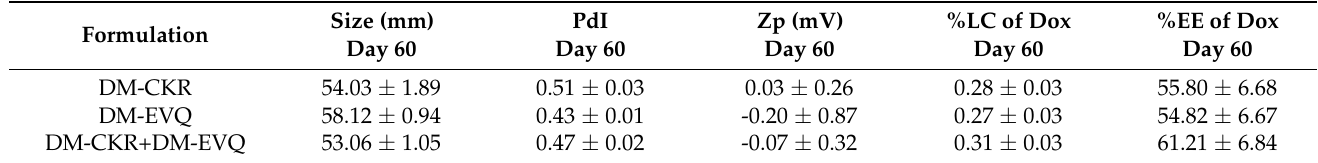
Table 3. Particle size, polydispersity index (PdI), zeta potential (ZP), and % entrapment efficacy (EE) and %loading capacity (LC) of DM-CKR, DM-EVQ, and DM-CKR+DM-EVQ on day 60 at − 80 ◦ C.